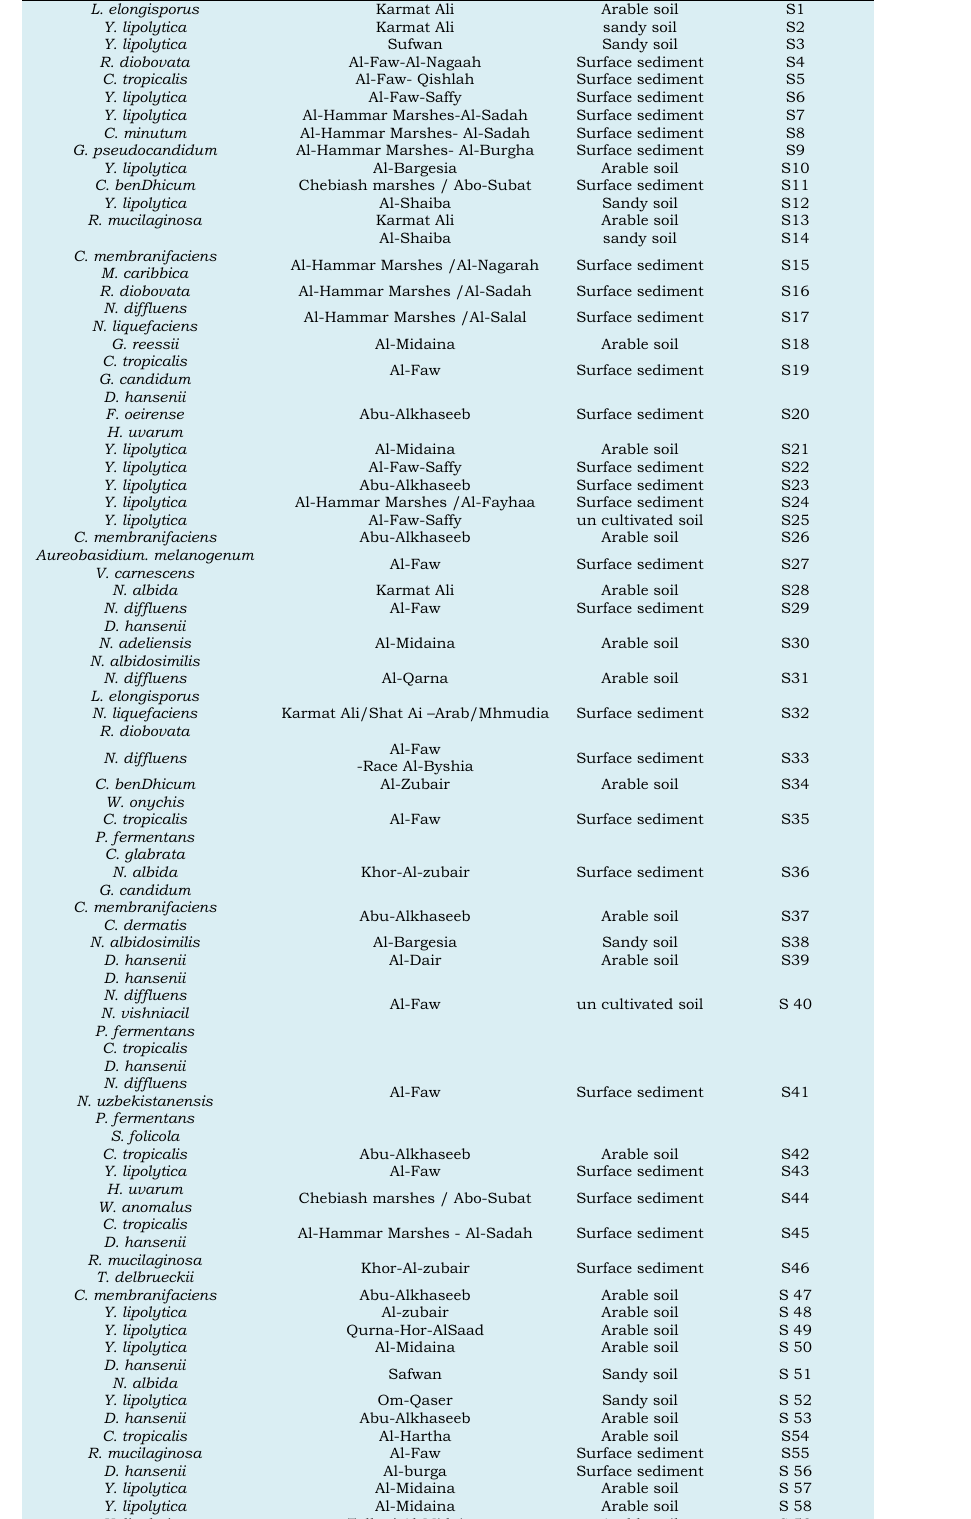
Table 7 Comparison between yeasts in sediment and soil